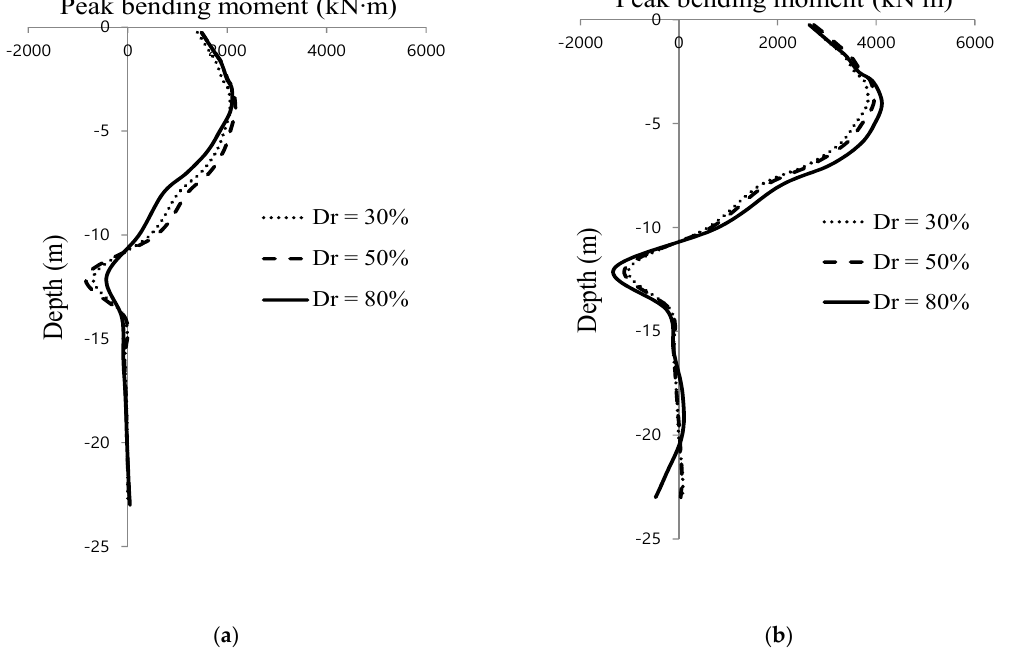
Figure 16. Maximum lateral pile displacement envelopes obtained from three different relative densities. ( a ) Input acceleration: 0.13 g; ( b ) Input acceleration: 0.25 g. Several meaningful characteristics of dynamic soil-pile-structure interaction in dry sand were estimated through a series of numerical analyses, which were described in this section. In dry sand, the effect of the inertial force induced by the superstructure is dominant, whereas the effect of the kinematic force induced by soil movement is not as significant. This kind of dynamic characteristic